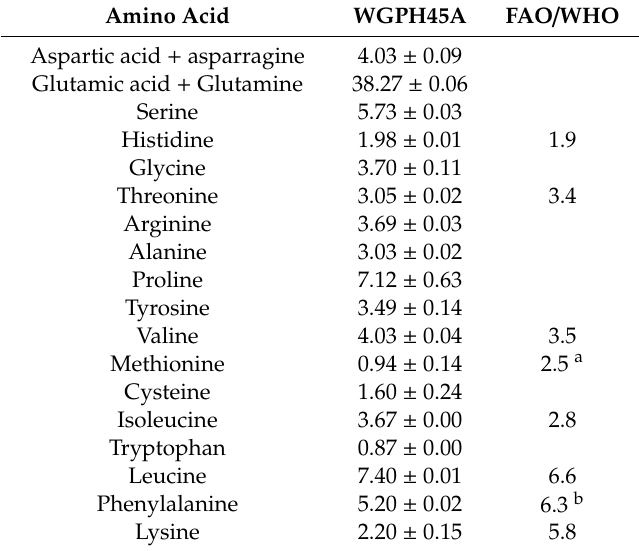
Table 2. Amino acid composition of WGPH45A. Values, showed as a percentage of total amino acid content, are mean ± standard deviation of